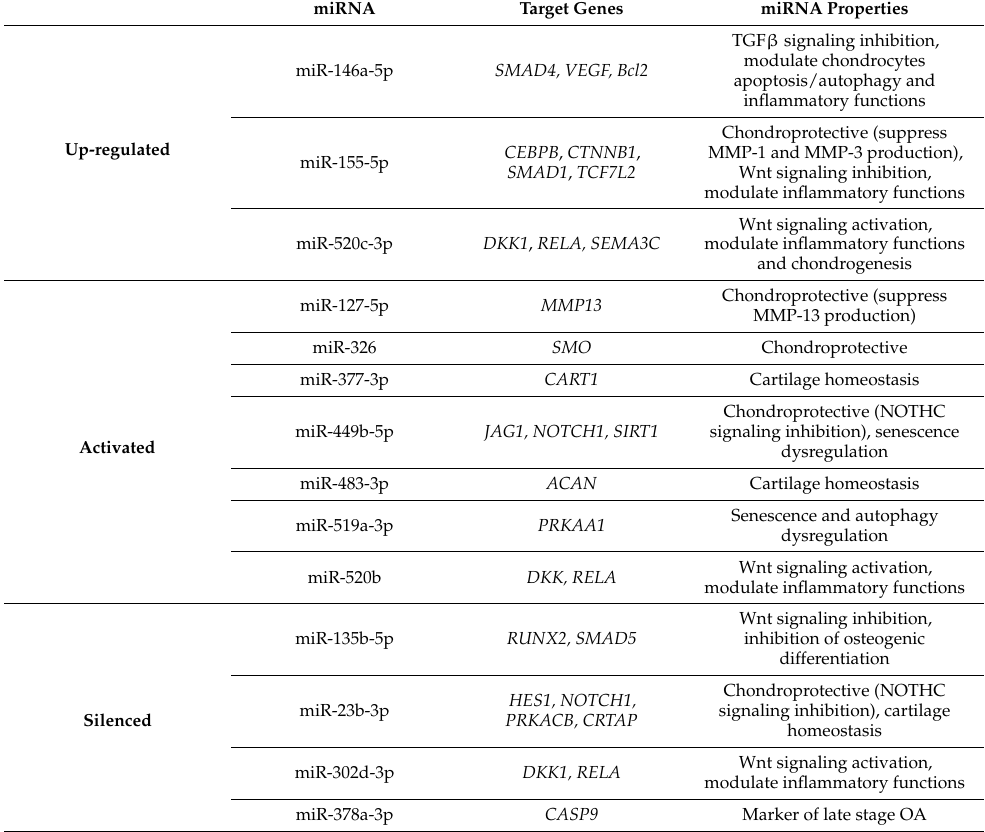
Table 3. miRNA experimentally observed as involved in osteoarthritis and modulated by IL-1 β